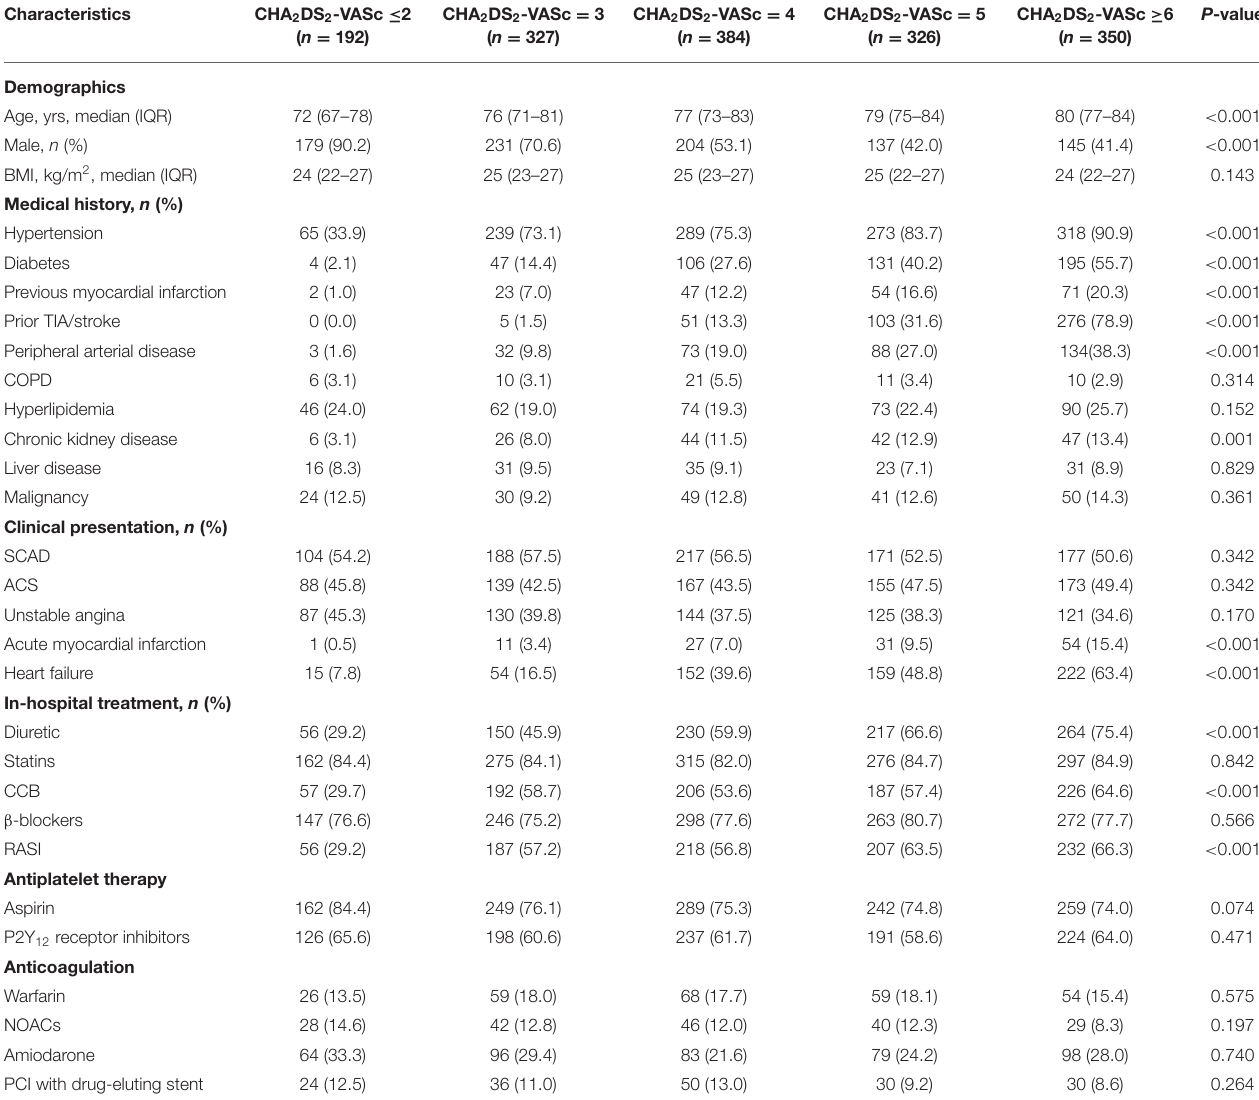
TABLE 1 | Baseline characteristics of elderly patients with CAD and AF according to the CHA 2 DS 2 -VASc score.